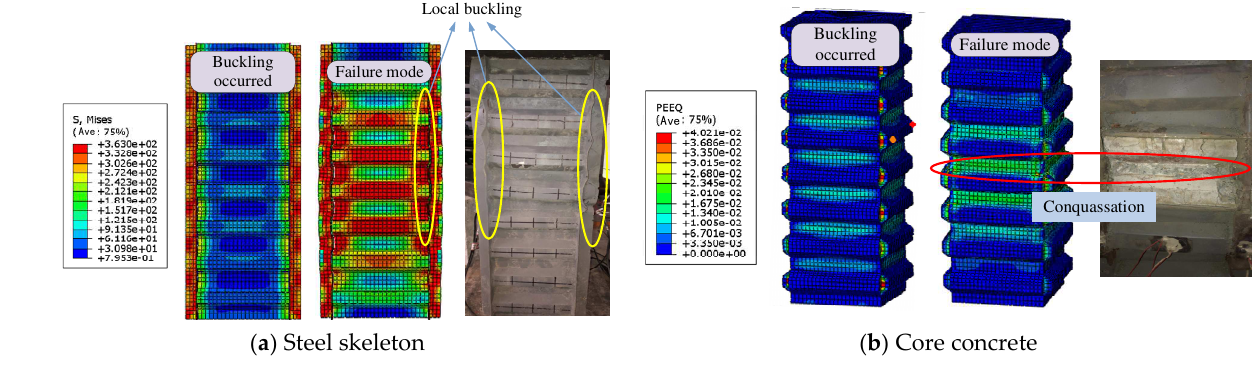
Figure 12. Comparison between test and FE.